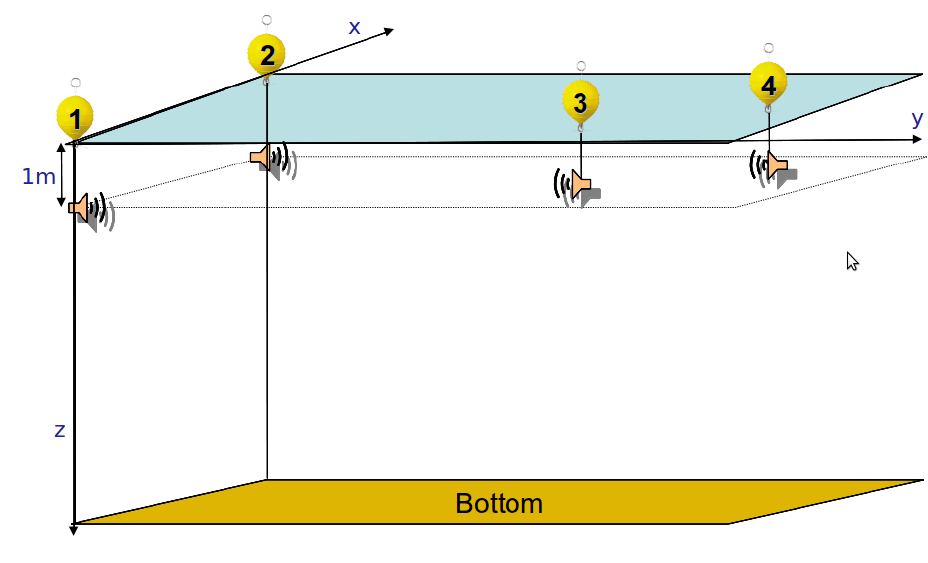
Figure 2. Positioning system